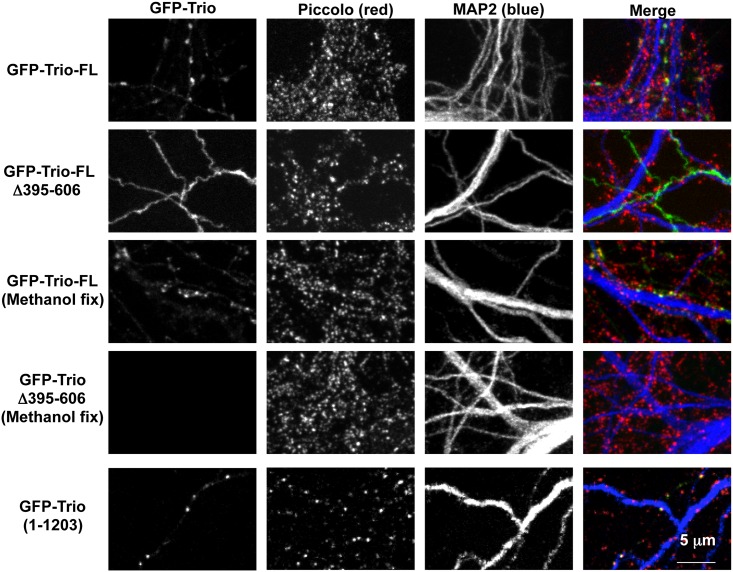
Trio requires Spectrin repeats 3 and 4 to be targeted to presynaptic boutons.Images of axons from neurons transfected with GFP-Trio-FL, GFP-Trio-FL(Δ395–606) or GFP-Trio(1–1203) growing along the dendrites of untransfected cells that have been fixed and immunostained with Piccolo (red) and MAP2 (blue). Neurons were fixed with methanol where indicated or formaldehyde (when fixative is not specified). Note that when GFP-Trio-FL is lacking amino acids 395–606 (Spectrin repeats 3 and 4), it did not localize to the presynapse and was readily extracted by methanol fixation. GFP-Trio (1–1203), which contains all the spectrin repeats, was targeted effectively to presynaptic sites.